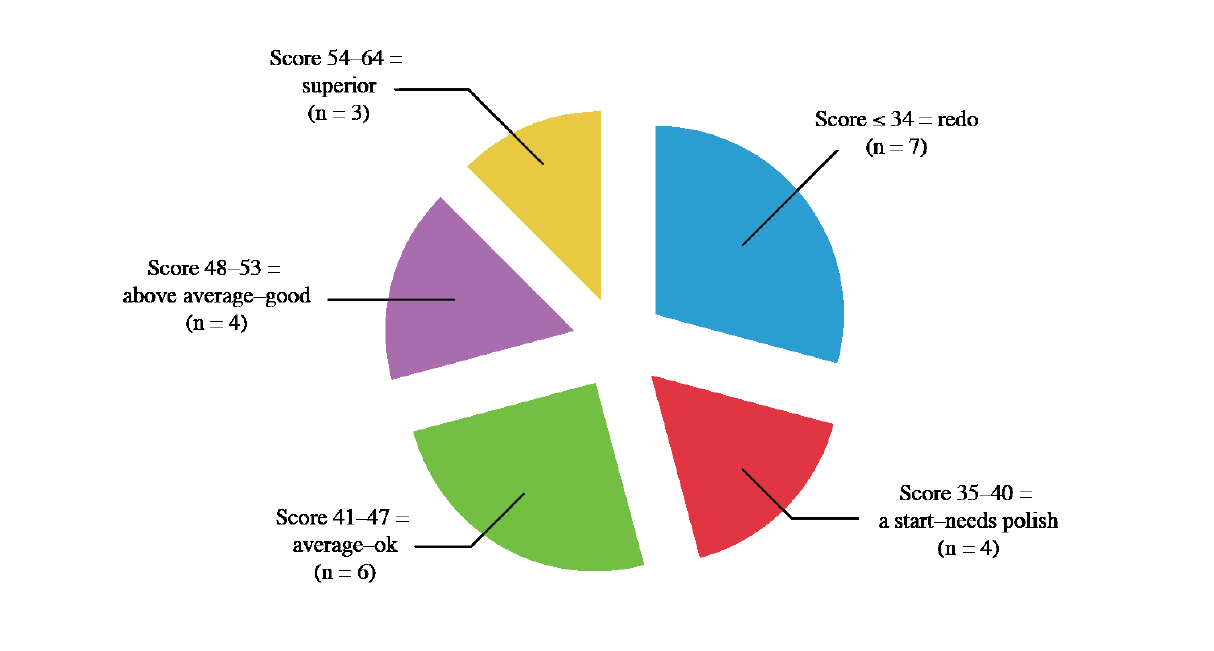
Figure 2. Distribution of courses evaluated by course quality with suggested